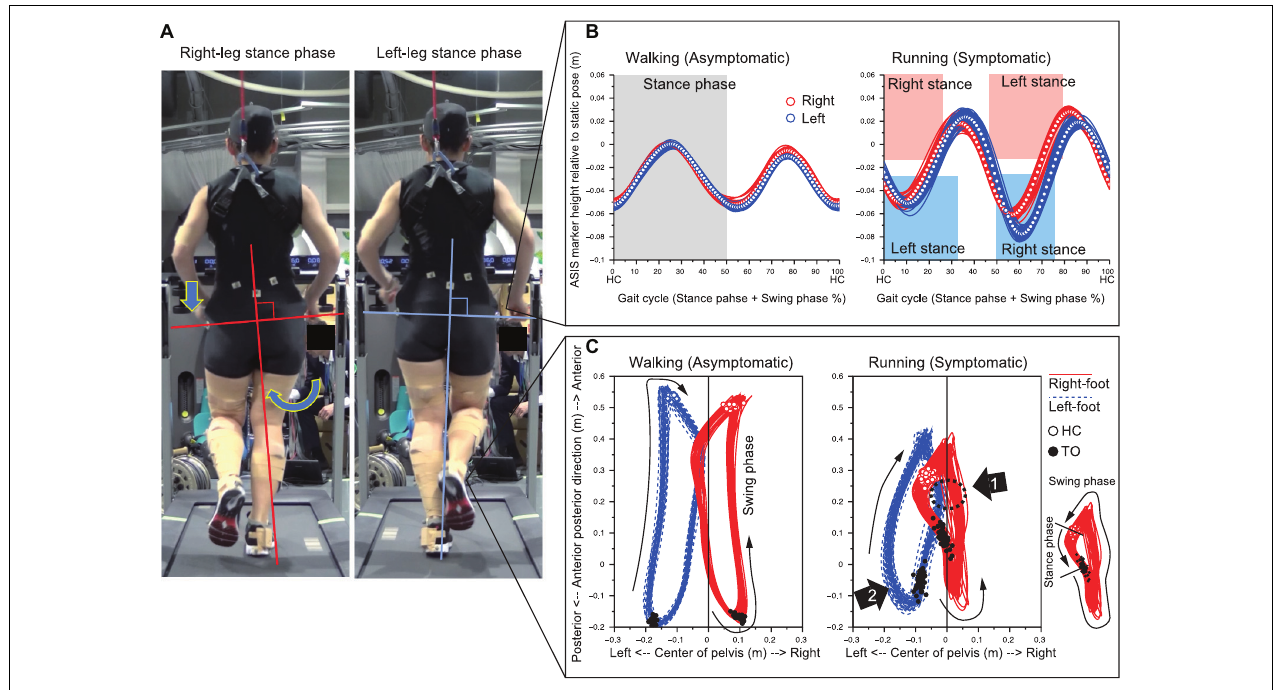
FIGURE 2 | Prominent left pelvis-drop observed during right-leg stance-phase (A) . The temporal change of the ASIS markers height illustrated that left pelvis-drop only occurred during right-leg stance-phase of running (B) . The top view of 3D trajectory of foot segment with respect to the pelvis coordinate system showed that right-foot trajectory medially shifted and impinged with left-leg area (Arrow 1). The left leg in turn circumducted to escape from right foot interference (Arrow 2) (C) .